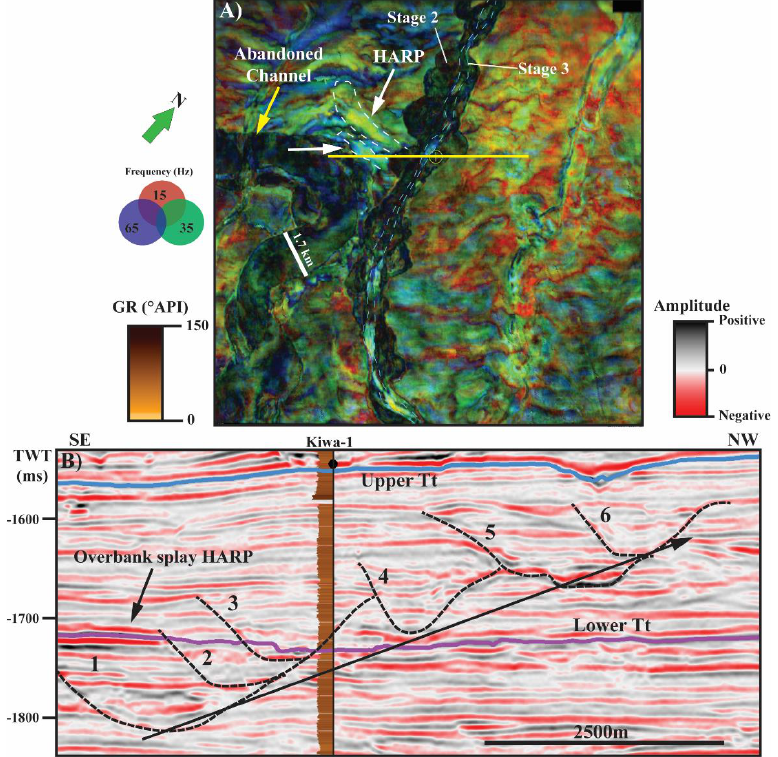
Figure 10. ( A ) Spectral decomposition RGB blend in the Hector-3D extracted along Lower Tt zoomed in to the Kiwa-1 Well. ( B ) Seismic amplitude section displaying six stages of channel complex